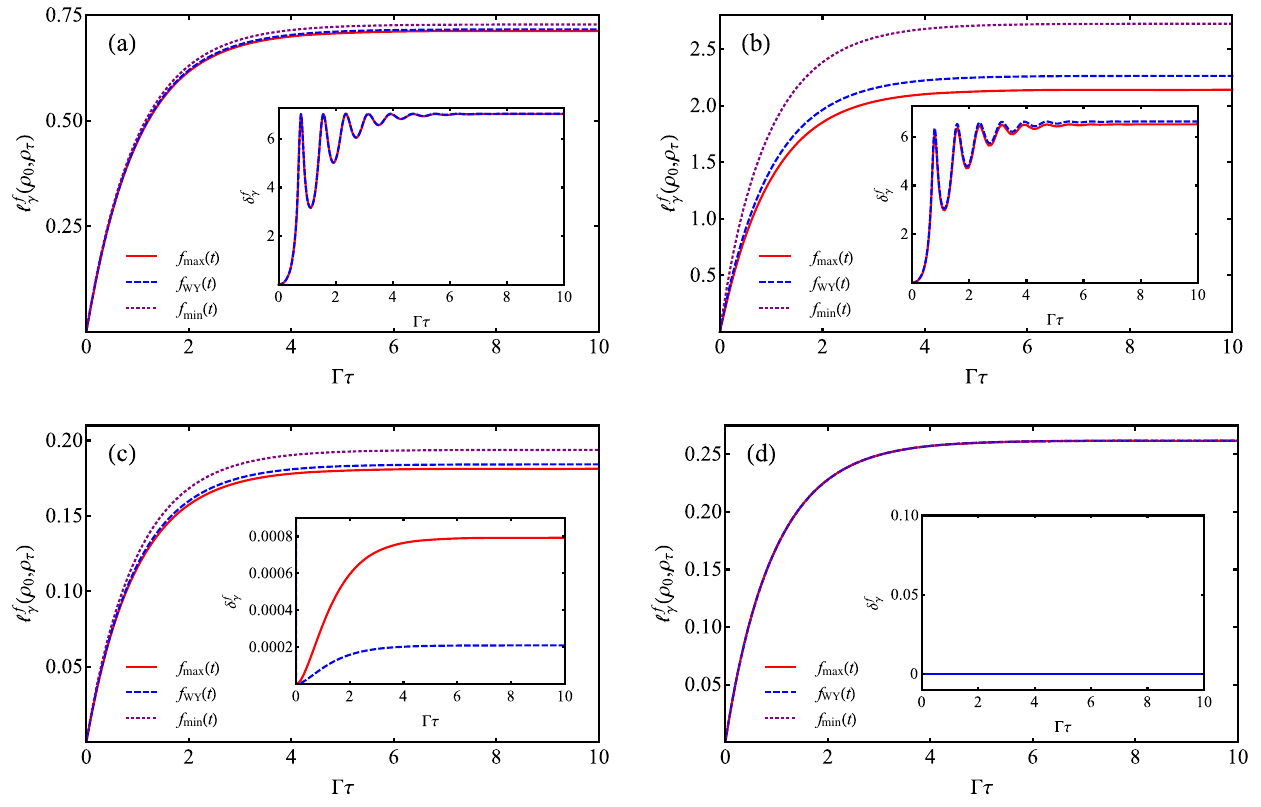
FIG. 3. Evolution path lengths l f γ for parallel dephasing processes by considering the contractive Riemannian metrics corresponding t Þ ¼ f t Þ (red solid line), f t Þ (blue dashed line), and f t Þ (purple dotted line) for to the following MC functions: f QF ð max ð WY ð min ð (a) r 0 ¼ 1 = 4 , θ 0 ¼ π = 4 , β ¼ 8 , (b) r 0 ¼ 3 = 4 , θ 0 ¼ π = 4 , β ¼ 8 , (c) r 0 ¼ 1 = 2 , θ 0 ¼ π = 4 , β ¼ 0 , and (d) r 0 ¼ 1 = 2 , θ 0 ¼ π = 2 , β ¼ 0 . The insets in each panel show the relative difference δ f γ , Eq. (19), for parallel dephasing processes by considering the quantum Fisher information metric (red solid line) and the Wigner-Yanase information metric (blue dashed line); such a relative difference can be regarded as an indicator of the tightness of the bounds (the smaller δ f γ , the tighter the